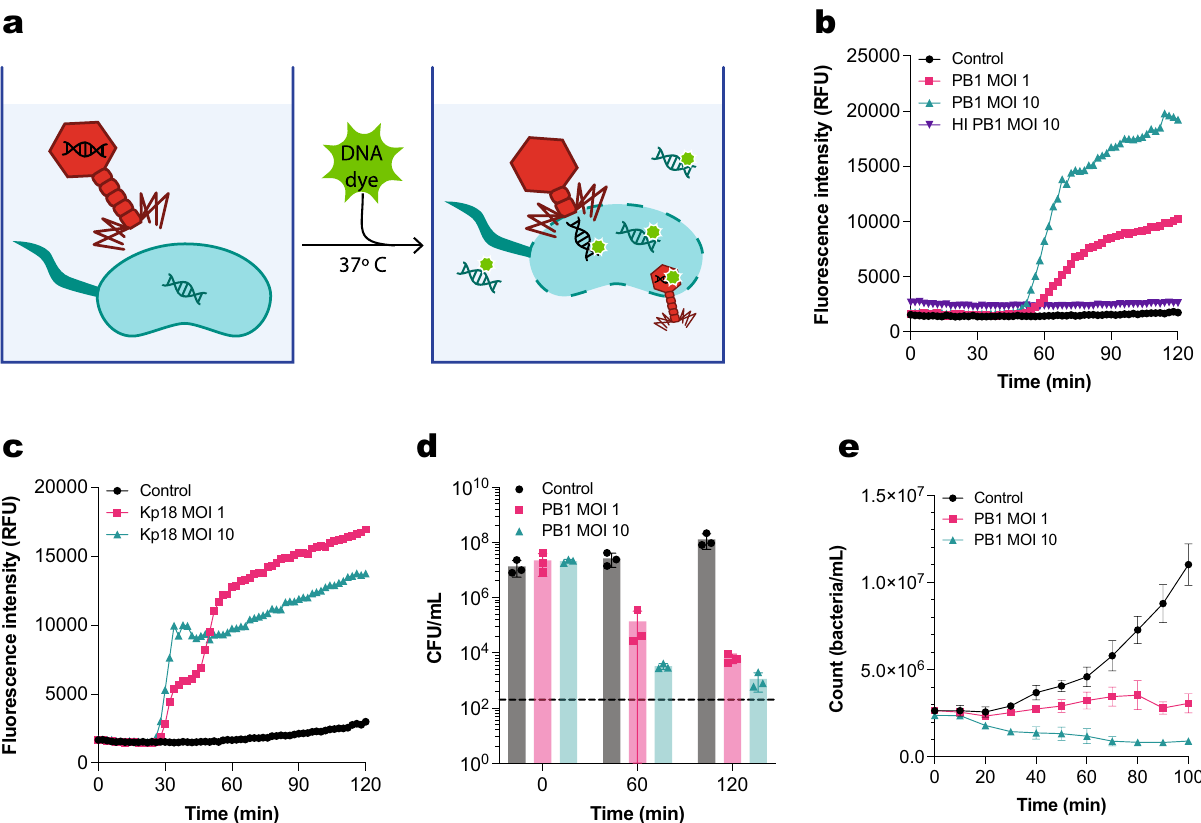
Figure 1. Fluorescent DNA dye assay detects phage-mediated killing. ( a ) Phage infection can be monitored in a 96-well plate setting using a membrane-impermeant DNA dye. The dye is added to a plate containing a phage-infected bacterial culture, which is then incubated at 37 °C. As the infection progresses, Sytox green will bind to phage DNA, DNA of damaged bacteria, and free bacterial DNA. The fluorescent signal of the DNA dye is measured over time. ( b ) Fluorescence intensity over time of P. aeruginosa infected with phage PB1 at an MOI of 1 and 10. Control are uninfected bacteria. Bacteria infected with heat-inactivated (HI) PB1 at an MOI of 10 are shown as a further control. ( c ) Fluorescence intensity over time of K. pneumoniae infected with phage Kp18 at an MOI of 1 and 10. Control are uninfected bacteria. ( d ) P. aeruginosa infected with phage PB1 at an MOI of 1 (pink) and 10 (green), or not infected (control, black) were plated at the initial time-point (0 min), after 60 min and after 120 min. Number of recovered colonies per plated volume is expressed as colony forming units per mL (cfu/mL). Black dotted line represents detection limit. ( e ) Bacterial concentration (count/mL) of a GFP- positive P. aeruginosa population in the first 100 min after infection with phage PB1 at an MOI of 1 or 10, as determined by means of flow cytometry. The concentration of an uninfected population is shown as control. ( b , c ) A representative graph of at least three independent experiments is shown. ( d , e ) Data represent mean ± SD of three independent